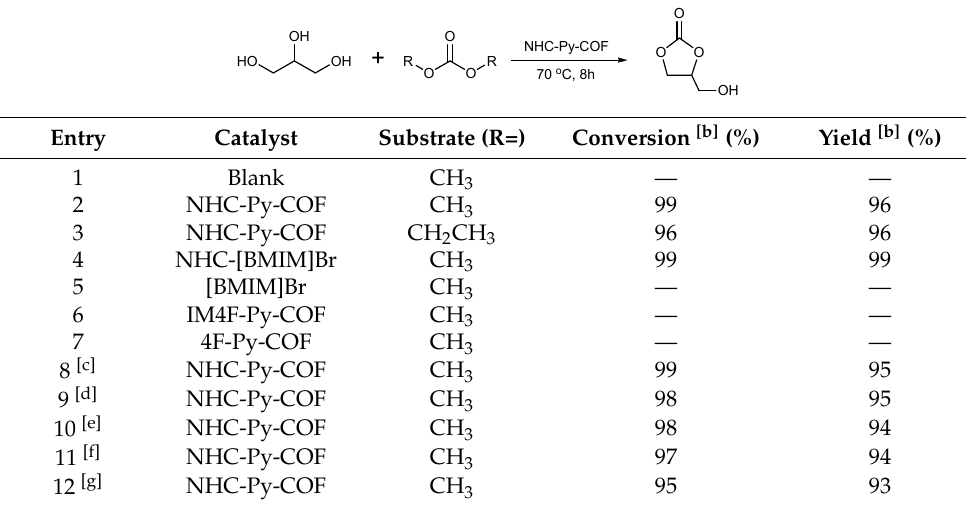
Table 2. Transesterification of glycerol with dialkyl carbonates over NHC-Py-COF. [a].